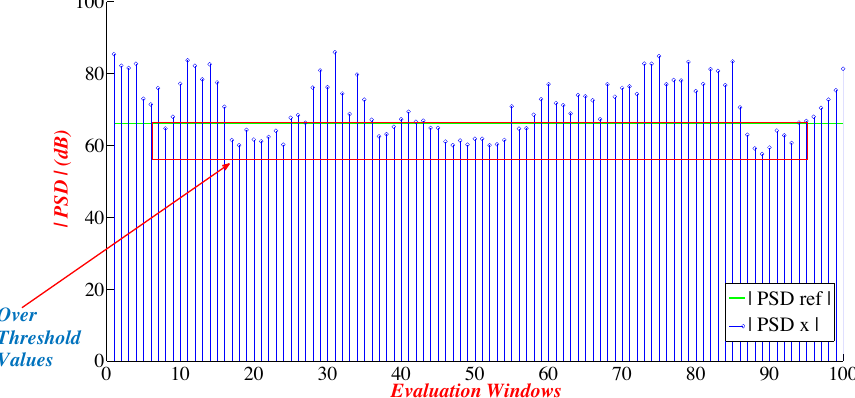
Figure 5. Comparison between power spectral density (PSD) PSD frame and PSD ref for signal x ( t ) .